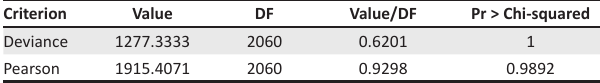
TABLE 9: Deviance and Pearson goodness-of-fit statistics. Criterion